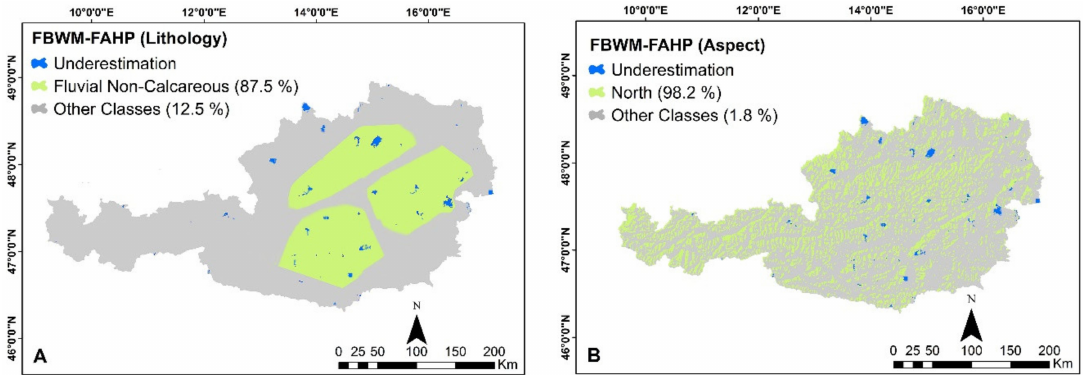
Figure 8. Spatial location of overestimations, in relationship with the imbalanced classes.